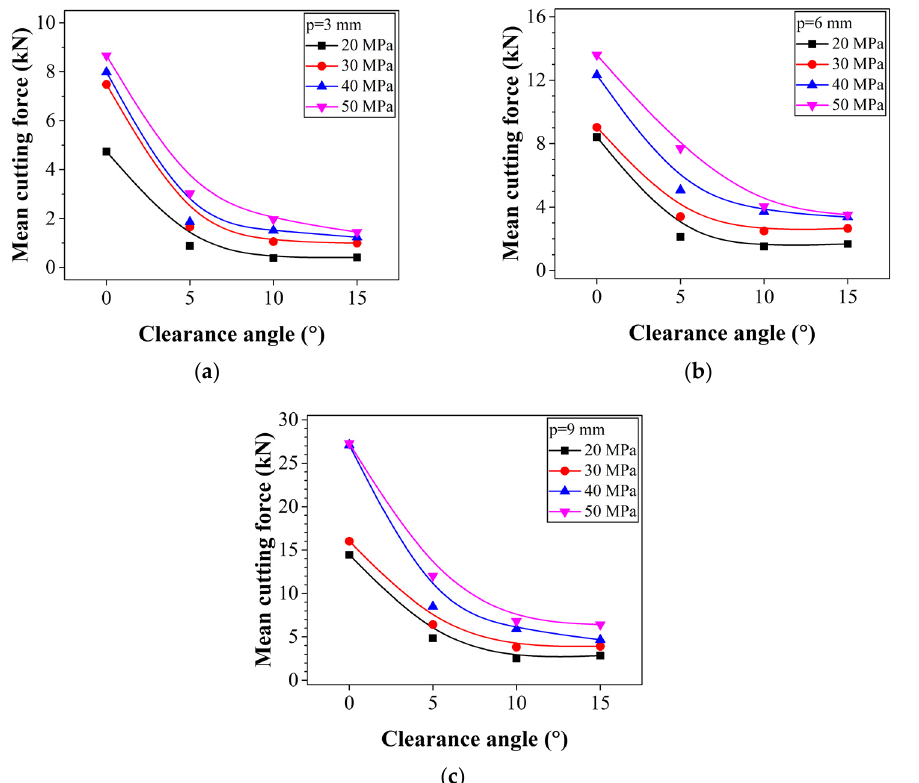
Figure 9. Relationship between the mean cutting force and clearance angle cutting depths ( p ) of: ( a ) 3 mm, ( b ) 6 mm, and ( c ) 9 mm. ( a ) 3 mm, ( b ) 6 mm, and ( c ) 9